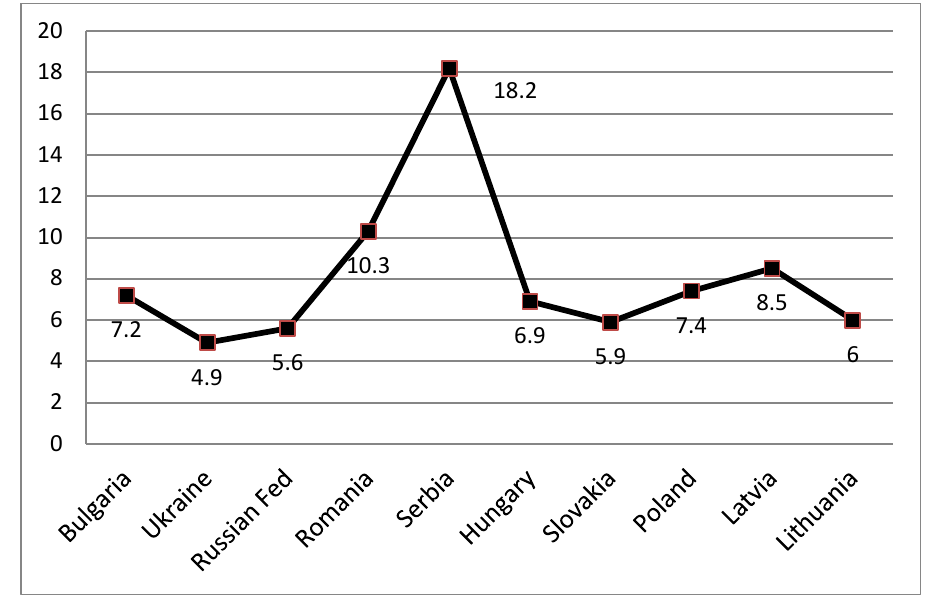
Fig. 1 . Mortality associated with physical inactivity